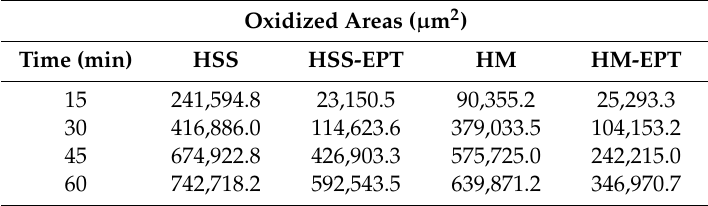
Table 7. Evolution of oxidized areas corresponding to circular crowns of specimens.